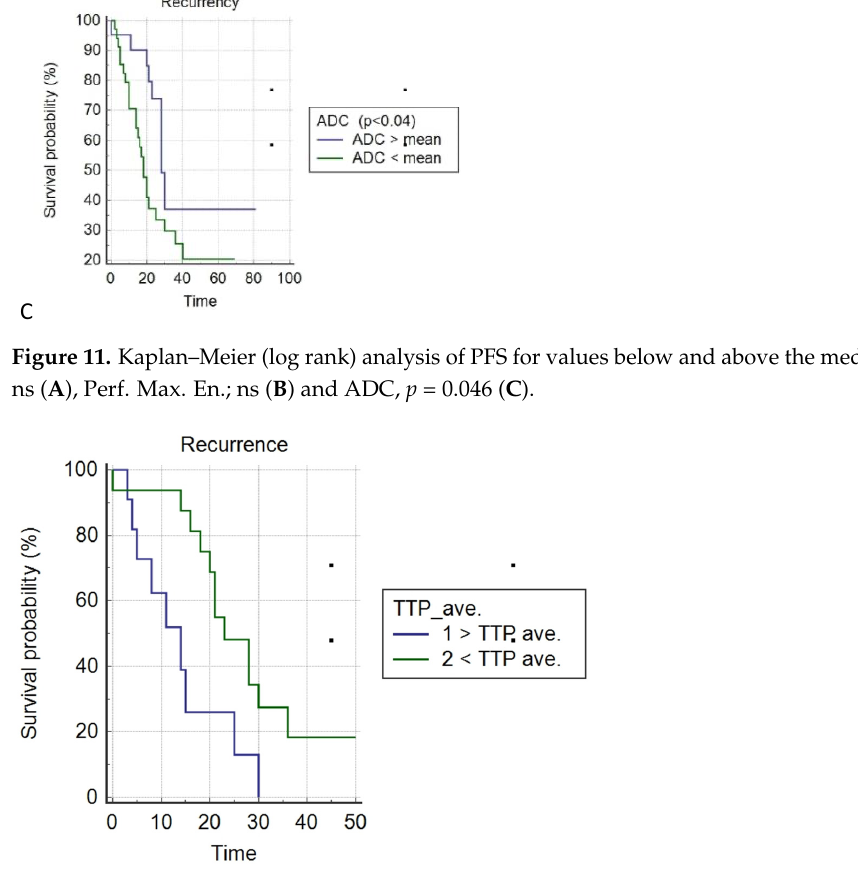
Figure 12. Kaplan–Meier (log rank) analysis of PFS for values below and above the mean TTP among patients treated with bevacizumab (Chi-squared = 6.2305; DF 1; p = 0.0126).